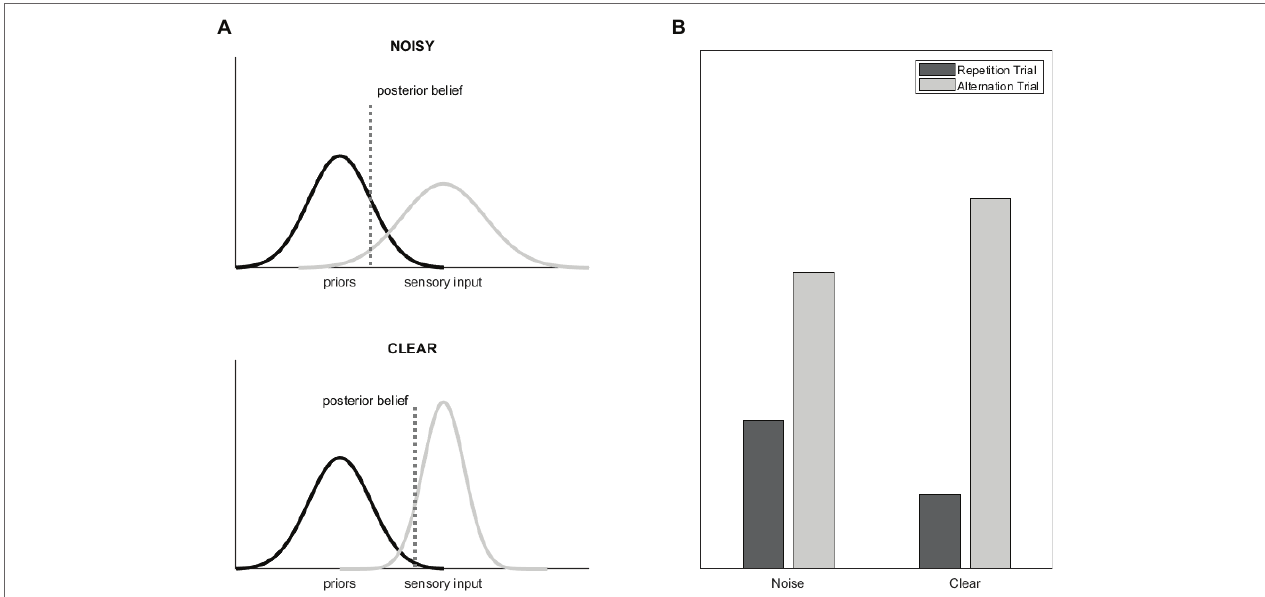
FIGURE 1 | (A) The graphs show the Gaussian probability distributions that represent the distribution of the priors (i.e., the a priori beliefs, black) and of the sensory evidences (gray) as well as the resulting posterior beliefs (dotted line) for a situation where the statistics-based priors are kept constant and the precision of the sensory stimuli is modulated (for example by adding noise to the images). Precision can be understood as the inverse of the distribution width. Reducing the relative precision of the sensory input biases the posterior beliefs toward the priors and thereby reduces predictive error (figure adapted from Adams et al., 2013). (B) Theoretical BOLD signal magnitudes for alternating and repeating stimulus pairs and for stimuli with and without noise, separately. Note that these results assume that predictive error is reflected in the magnitude of RS (Grotheer and Kovács,